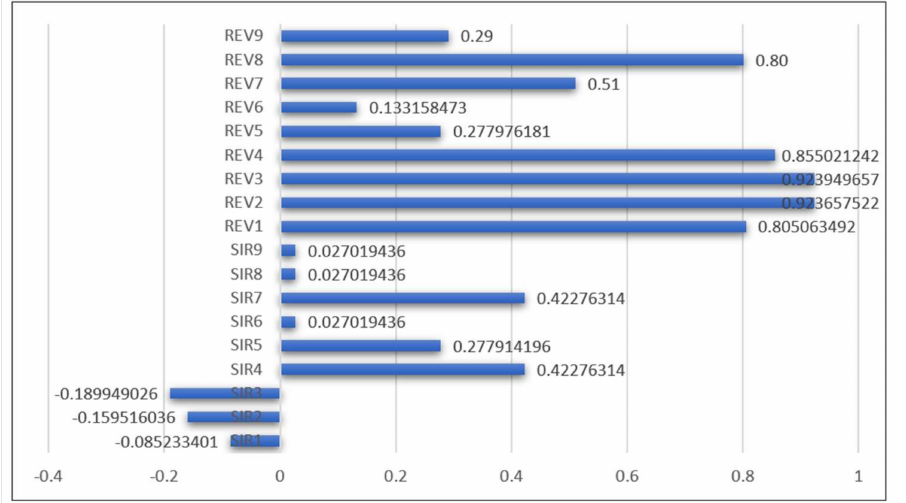
Figure 5. Pearson Correlation of Researchers’